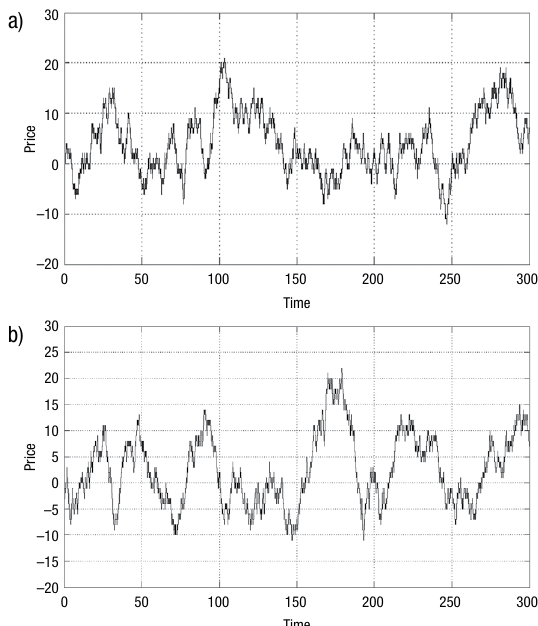
Fig. 6. Primary RW+ price inertia (simulated path 1) (a), Primary RW + price inertia (simulated path 3)